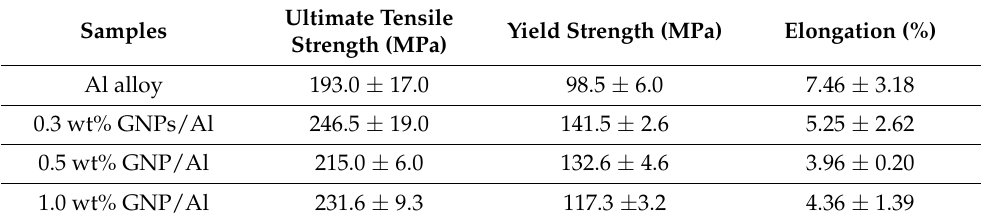
Figure 10. Tensile properties of Al alloy and GNPs/Al composites with different graphene contents. ( a ) Tensile stress – strain curve; ( b ) relationship between fracture elongation and YS, UTS. Table 3. Mechanical properties of GNPs/Al composites .